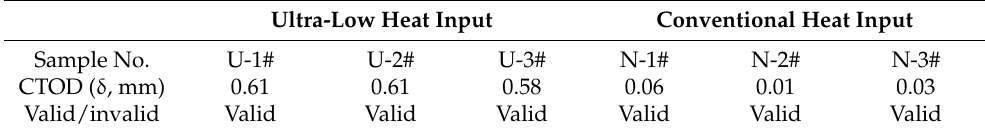
Table 4. CTOD results of CGHAZs under two welding heat inputs.